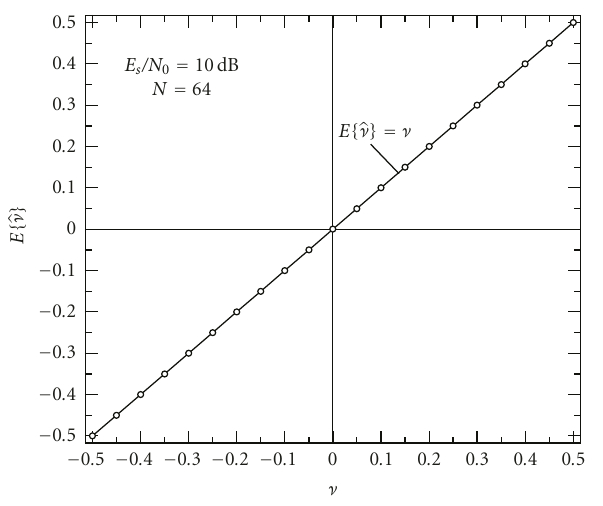
Figure 4: Mean normalized frequency estimates versus ν .